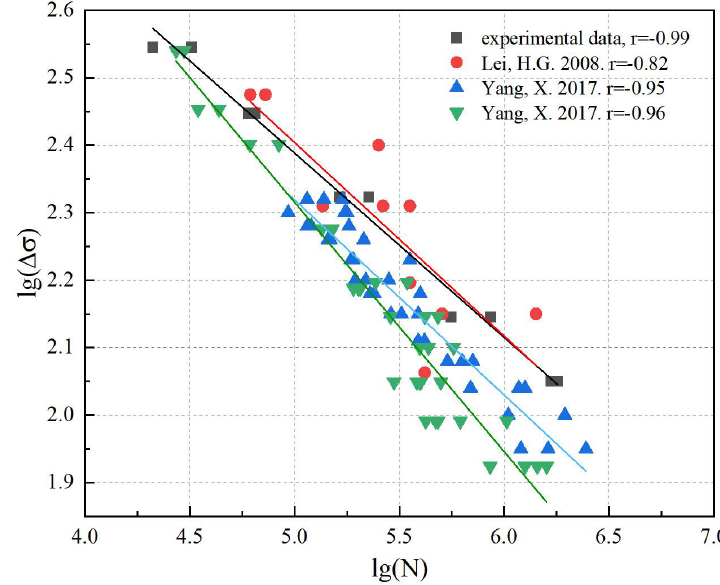
Figure 12. S-N curves of high-tensile